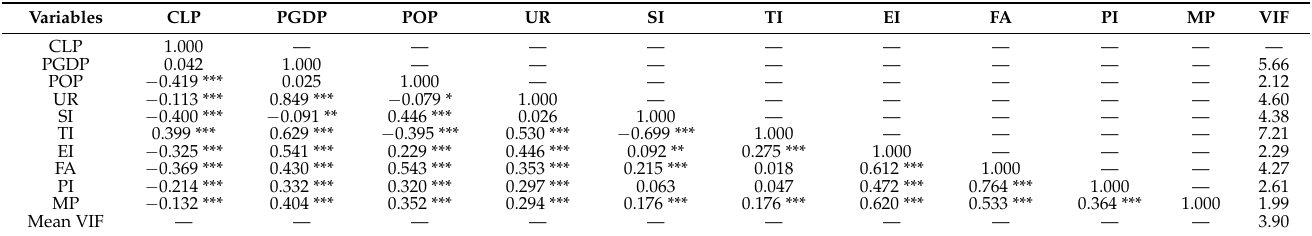
Table 4. The correlation matrix of the variables and the results of the multicollinearity tests.